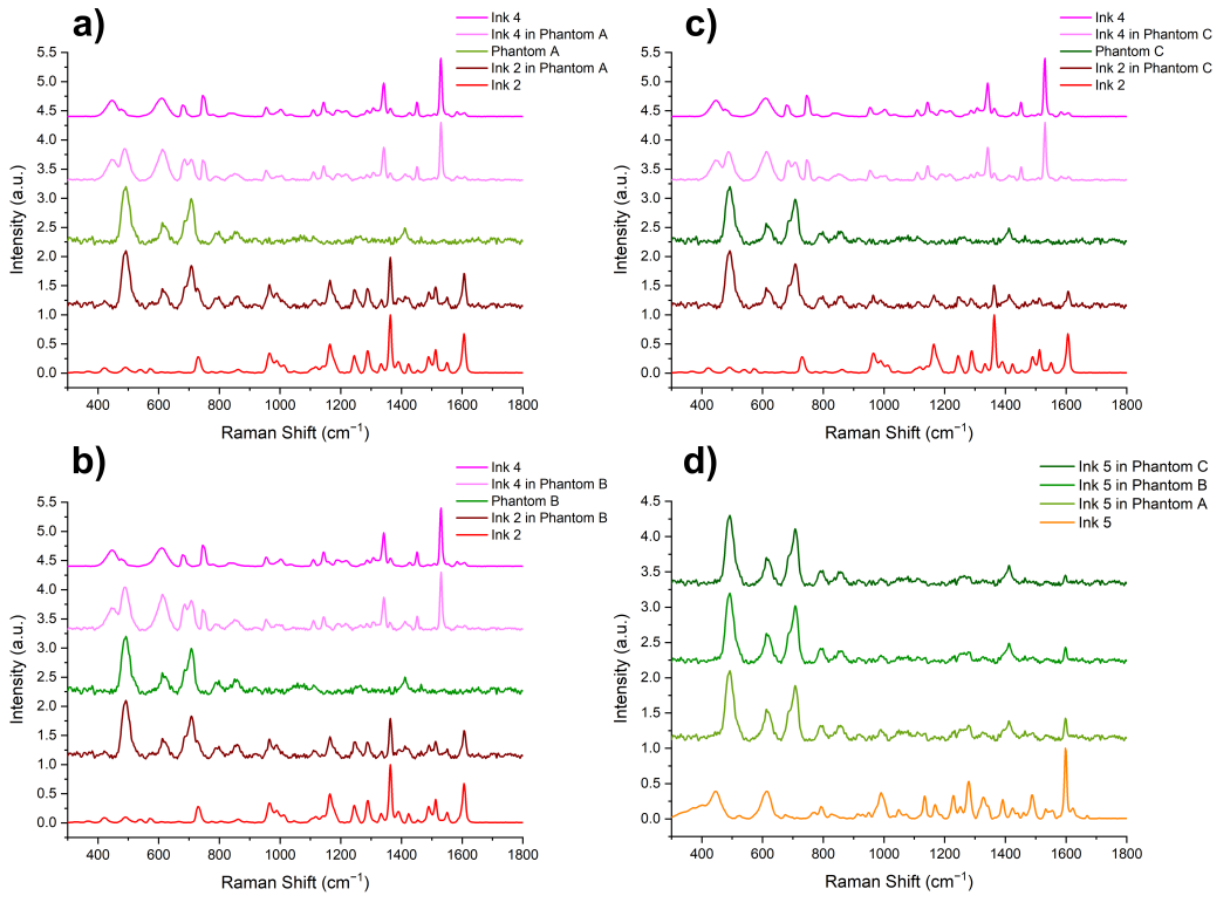
Figure 4. ( a – c ) Smoothed and baseline-corrected spectra of Phantoms A, B, and C in comparison to the spectra of tattoos made in them with Inks 2 and 4; ( d ) Ink 5 in comparison to Ink 5 injected into Phantoms A, B, and C. As can be seen in Figure 4a–c, the tattoo spectra consist of combinations of bands characteristic of pure ink and the phantom. The bands characteristic of Ink 2, at 1362 and 1606 cm − 1 , are potentially visible in the spectra of tattoos made in all three Phantoms. This also applies to the bands at 1340 and 1530 cm − 1 corresponding to Ink 4. An increase in the value of the scattering coefficient affects a decrease in the signal intensity of the bands characteristic of the inks. This tendency is especially visible in Figure